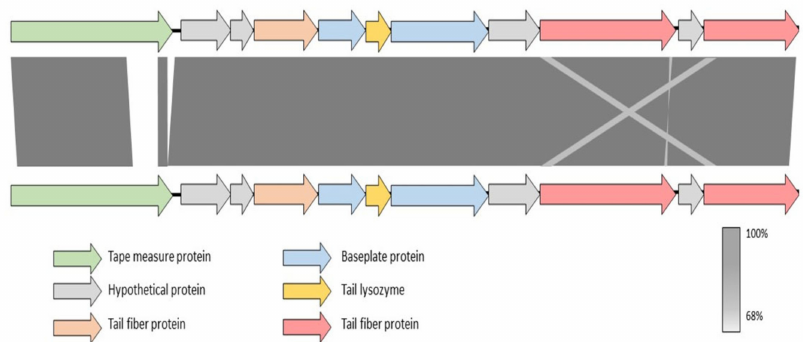
Figure 5. Tail fiber region of KIL3b (top) and KIL5 (bottom). The di ff erent genes are annotated as previously published [13]. Homology is based on nucleotide level (BLASTn). The tail fiber region of both phages is more or less identical except for the tape measure protein and a small translocation between the two major tail fiber